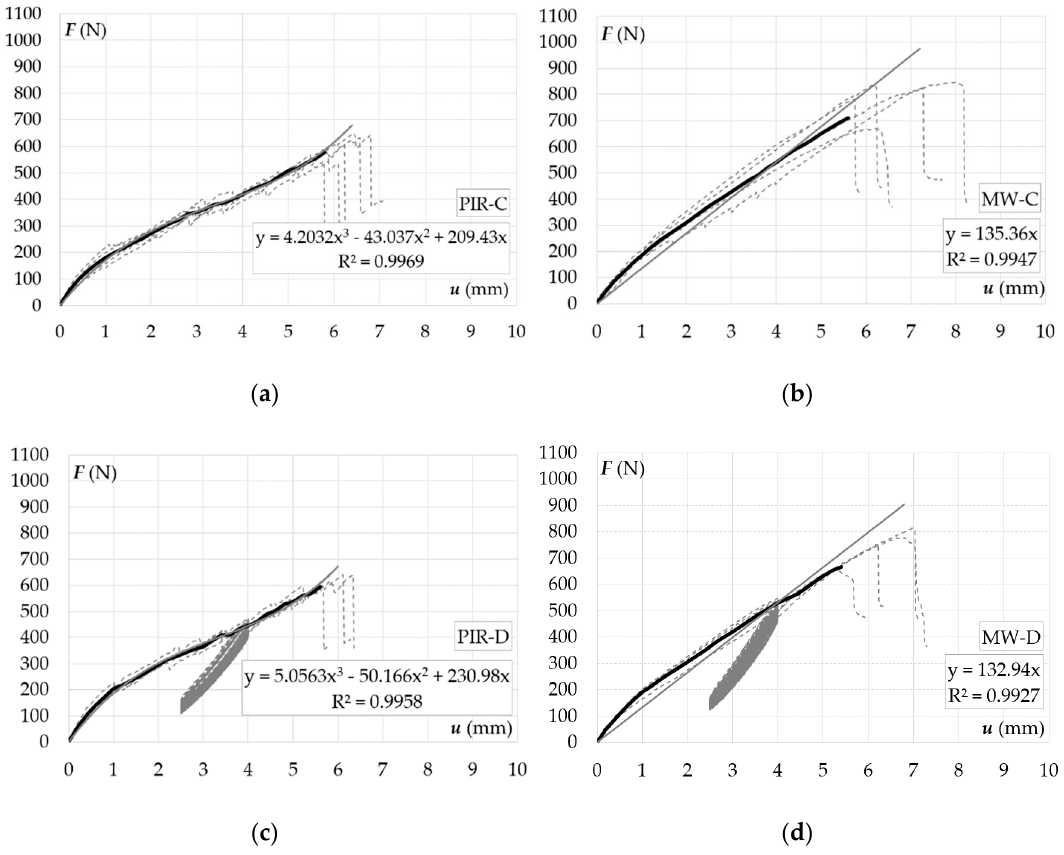
Figure 7. Eccentric pull-out of a blind rivet from a sandwich panel facing: ( a ) static pull-out from a panel with a PIR foam core, ( b ) static pull-out from a panel with a mineral wool core, ( c ) quasi-cyclic pull-out from a panel with a PIR foam core, ( d ) quasi-cyclic pull-out from a panel with a mineral wool core.